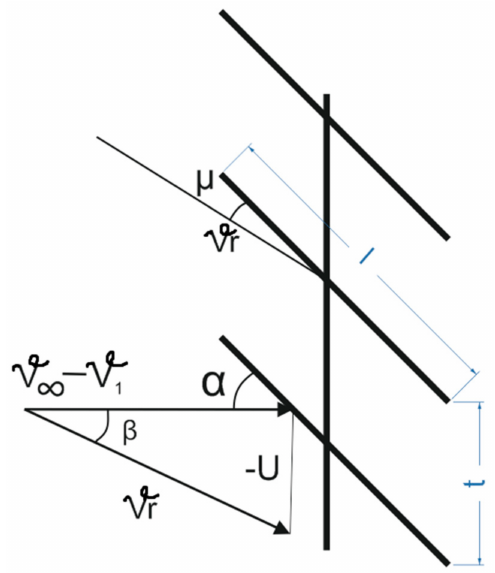
Figure 6. Lost and relative